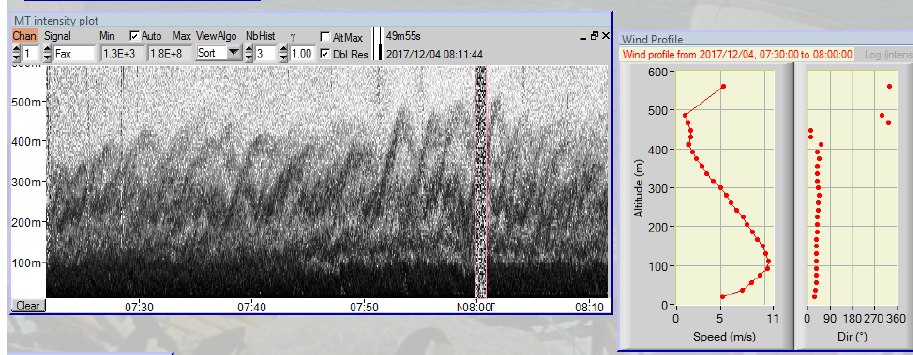
Figure 32. Example of the wavy braid pattern occurring in the layer with a negative wind speed vertical gradient: ( left panel ) Sodar echogram and ( right panel ) wind speed profile obtained 4 December 2017 at the SMART